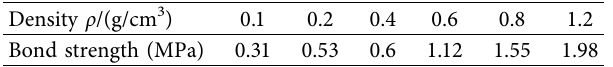
Table 2: Relationship between bond strength and density. Density ρ /(g/cm 3 )